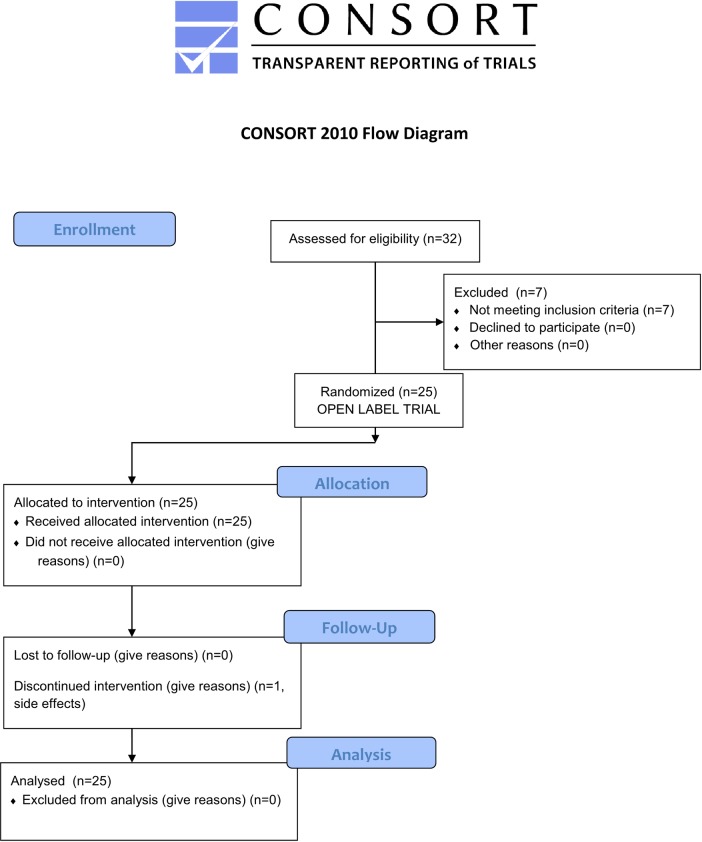
CONSORT flowchart of the open-label trial.